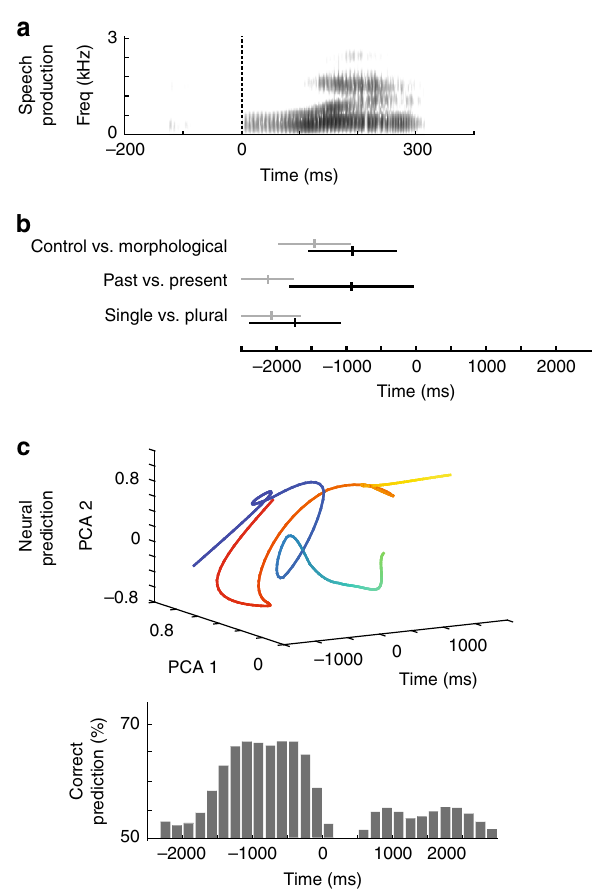
Fig. 5 Predictive encoding of planned in fl ections prior to speech onset. a Example of a target word speech spectrogram. Neural data were aligned to